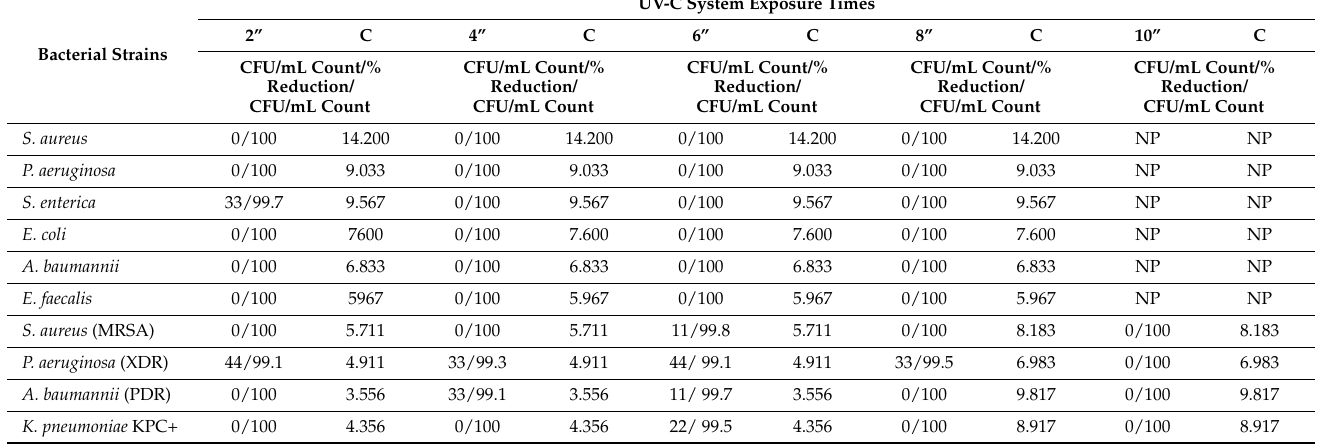
Figure 5. Efficacy of the UV ‐ C system in reducing several bacterial strains expressed in log 10 reduction of CFU/mL; CFU, colony forming units; A. baumannii , Acinetobacter baumanni ; Ab PDR, Acinetobacter baumannii Pandrug ‐ resistant; E. coli , Escherichia coli ; E. faecalis , Enterococcus faecalis ; Kp KPC+, Klebsiella pneumoniae produtora de carbapenemase (KPC+); MRSA, Staphylococcus aureus re ‐ sistente à meticilina; P. aeruginosa , Pseudomonas aeruginosa ; P. aeruginosa XDR, Pseudomonas aeru ‐ ginosa, Extensively drug ‐ resistant; S. aureus , Staphylococcus aureus ; S. enterica , Salmonella enterica.